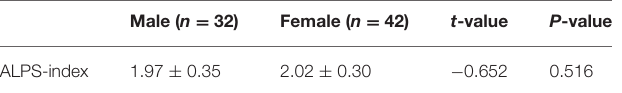
TABLE 4 | ALPS-index in different sex groups.